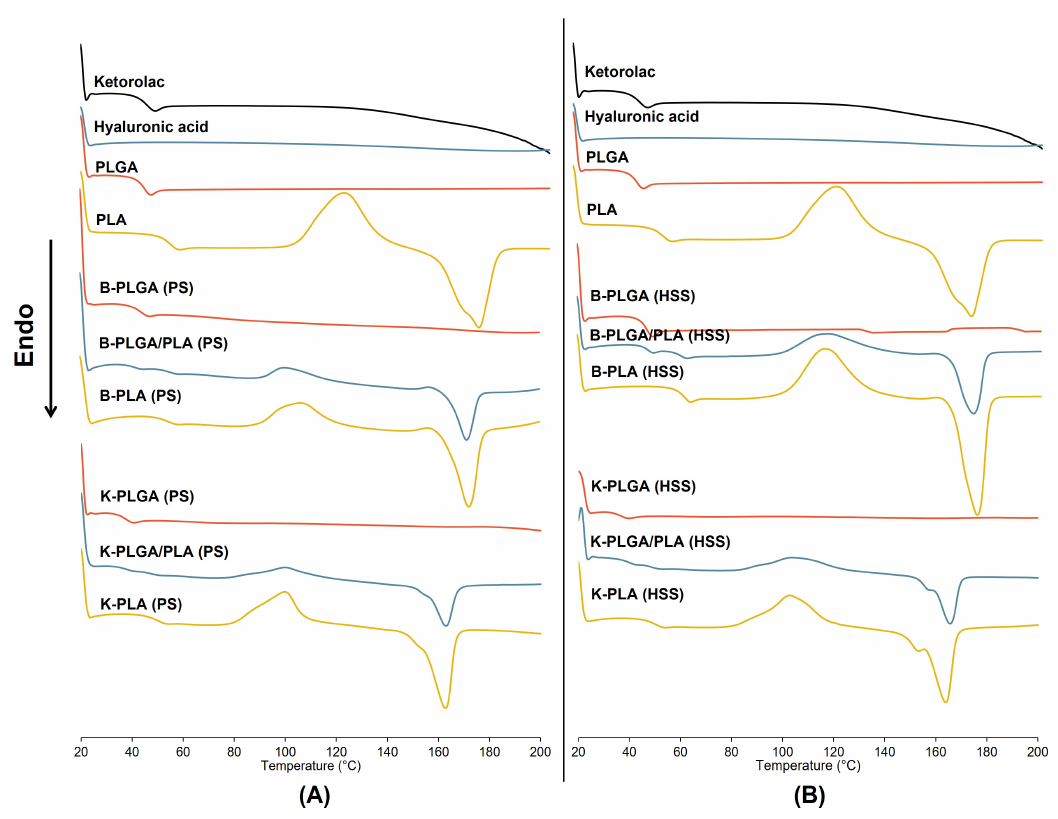
Figure 2. Differential scanning calorimetry thermograms of blank (B ‐ PLGA, B ‐ PLGA/PLA, and B ‐ PLA) and ketorolac ‐ loaded microparticles (K ‐ PLGA, K ‐ PLGA/PLA, and K ‐ PLA) prepared by PS ( A ) and HSS ( B ) techniques. Table 2. Temperatures of glass transition (T g ), cold crystallization (T cc ), and melting (T m ) and en ‐ thalpies of cold crystallization ( Δ H cc ) and melting ( Δ H m ) of individual components, blank and drug ‐ loaded microparticles recorded from the second heating.